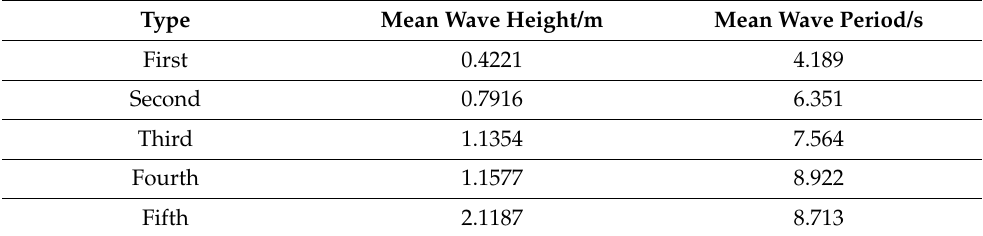
Table 1. Values of each cluster